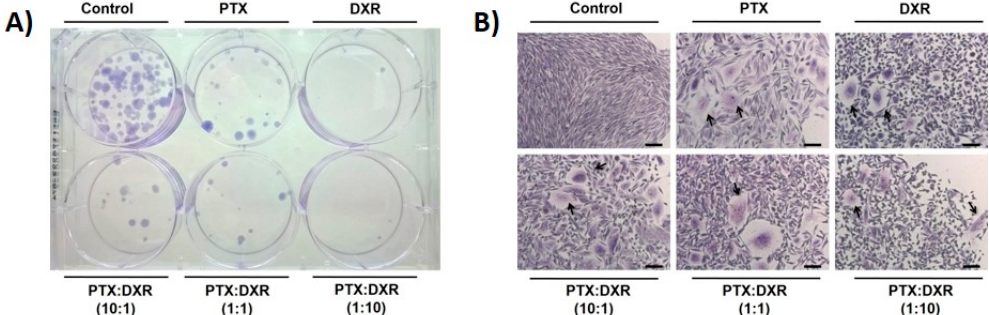
Figure 5. Colonies formed 21 days after re-plating MDA-MB-231 cells previously exposed to 70 nM of different treatments for 48 h. Photograph of plate containing colonies ( A ) and photomicrographs of crystal violet stained colonies, amplification 10×, scale bar = 100 μ m. Arrows indicate cells reassuming the senescence morphology ( B ). Abbreviations: DXR, doxorubicin; PTX, paclitaxel. Ratio in parenthesis refers to PTX:DXR molar ratio.